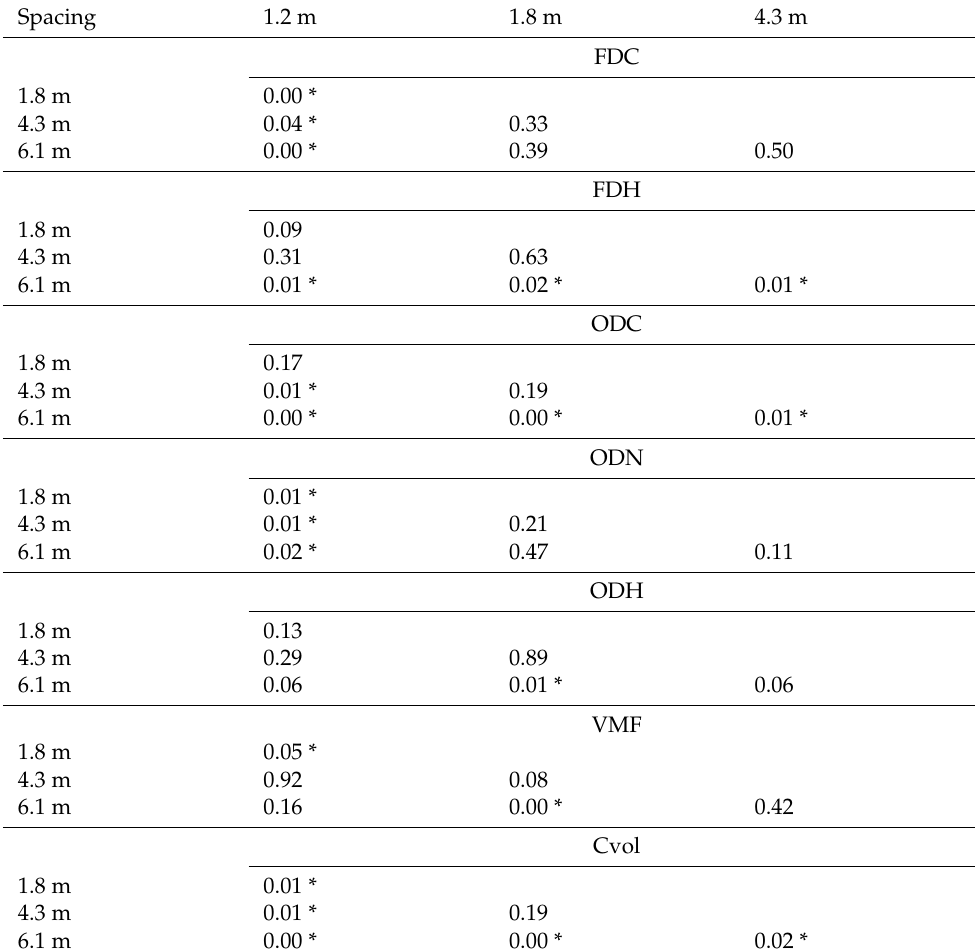
Table 3. Pairwise comparison of silvicultural treatments (spacing) on the chemical composition in white spruce using Wilcoxon’s post hoc test.